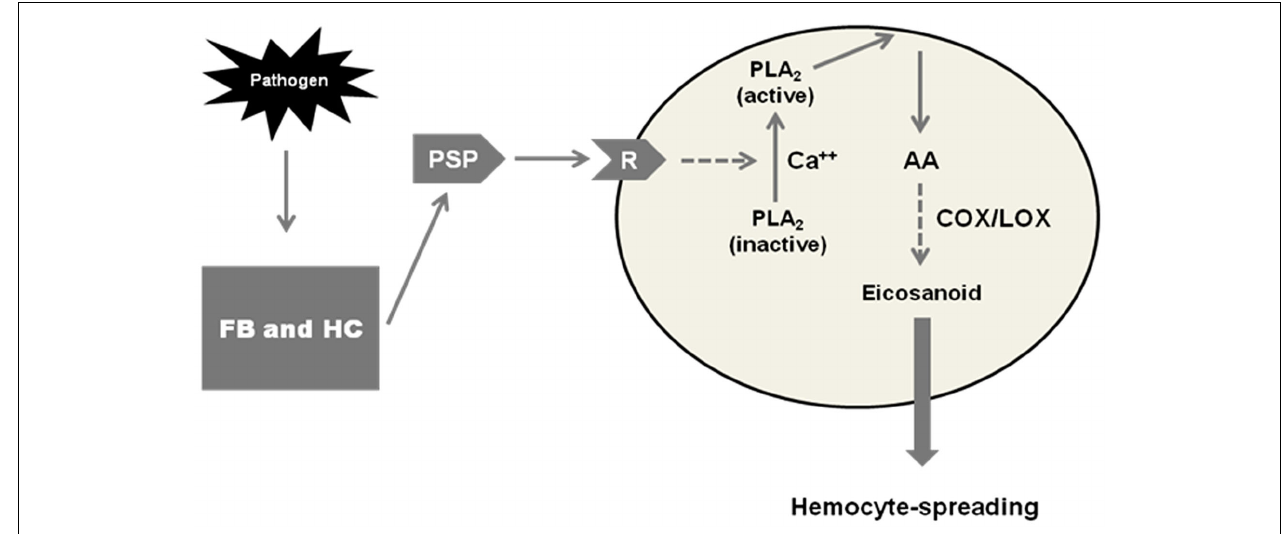
(R).The binding to the PSP-receptor induces activation of phospholipase A 2 (PLA 2 ), which hydrolyzes arachidonic acid (AA) from phospholipid substrates. AA is then oxygenated by COX or LOX enzymes to form PGs, and possibly other eicosanoids, that mediate hemocyte-spreading